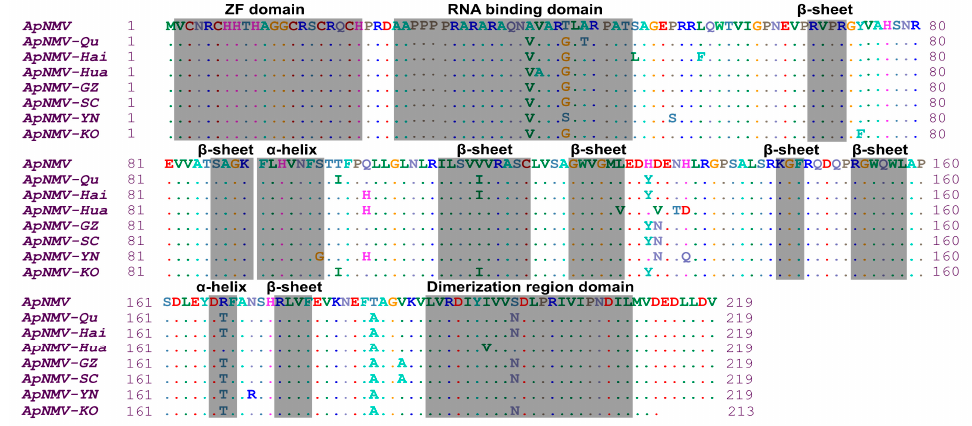
Figure 4. The alignment of eight amino acid residues of CP genes of ApNMV isolates.